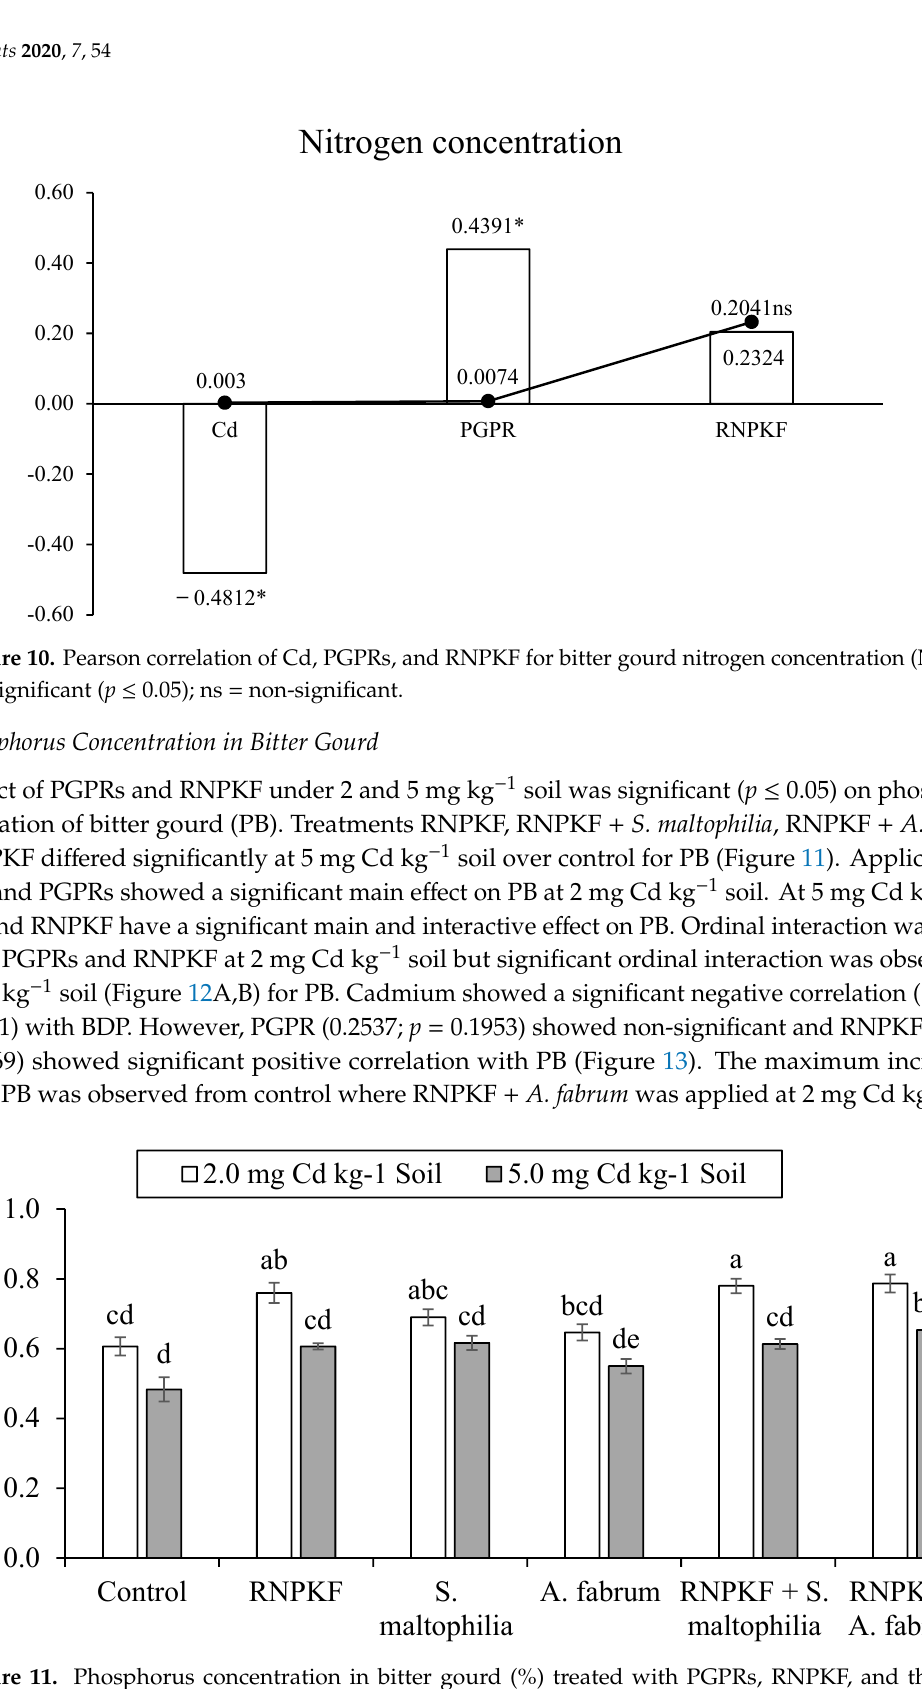
Figure 11. Phosphorus concentration in bitter gourd (%) treated with PGPRs, RNPKF, and their combination under 2 and 5 mg Cd kg − 1 soil. Different small letters express significant differences ( p ≤ 0.05).